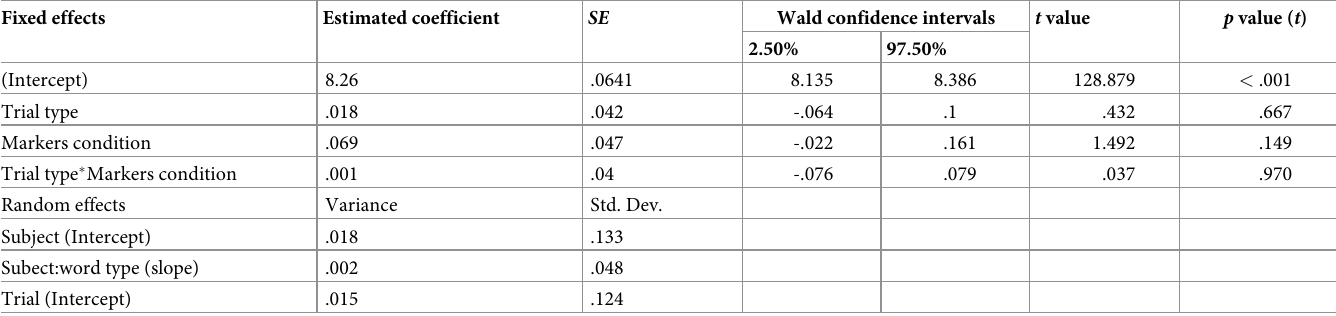
Table 8. Summary of the linear mixed-effects model of (log transformed) looking times on the categorisation trials for participants in experiment